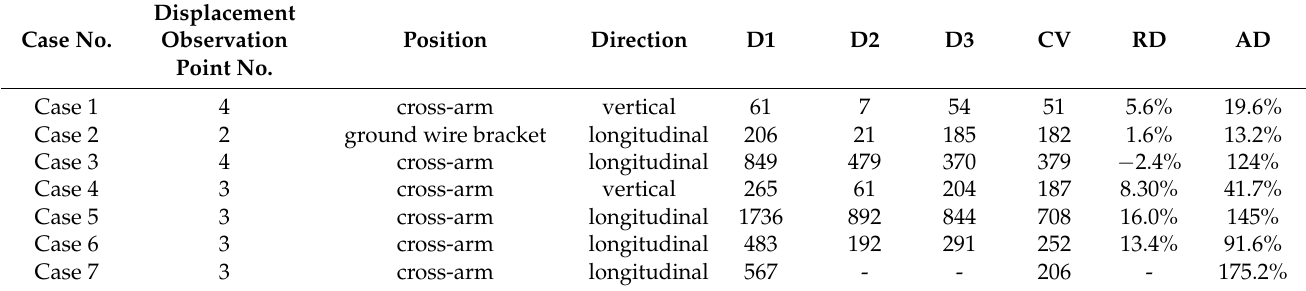
Table 5. Maximum displacements comparison between the tests and